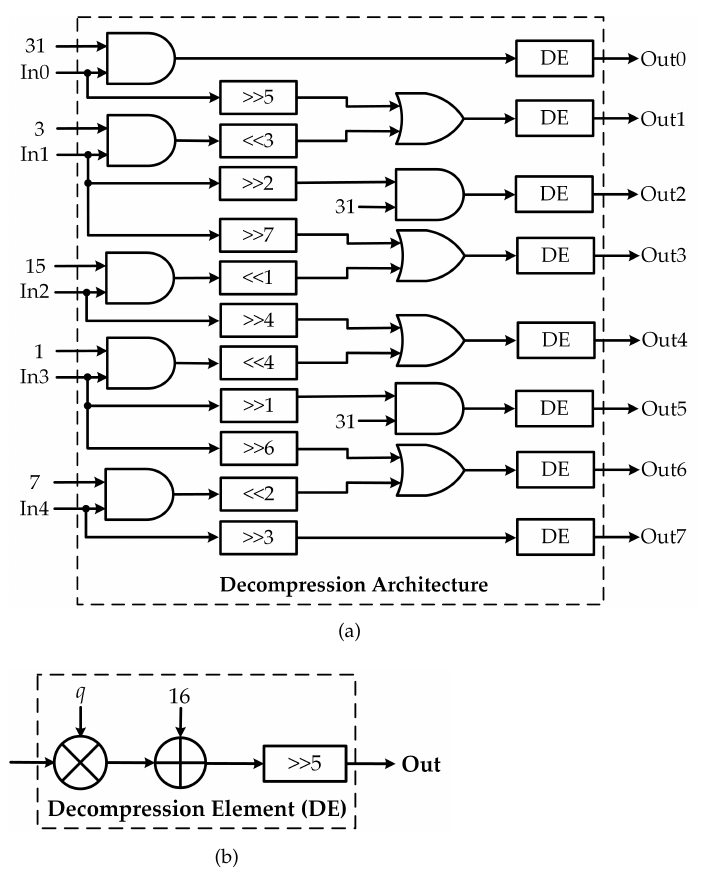
Figure 6. Decompression block: ( a ) decompression architecture, and ( b ) decompression